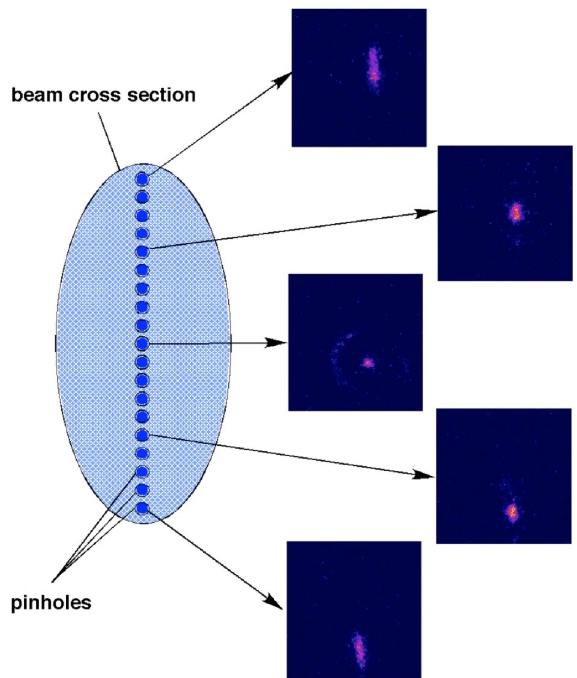
FIG. 7. (Color) Beam imaging technique to measure the phase space distribution f (cid:9) x; y; x 0 ; y 0 (cid:10) .